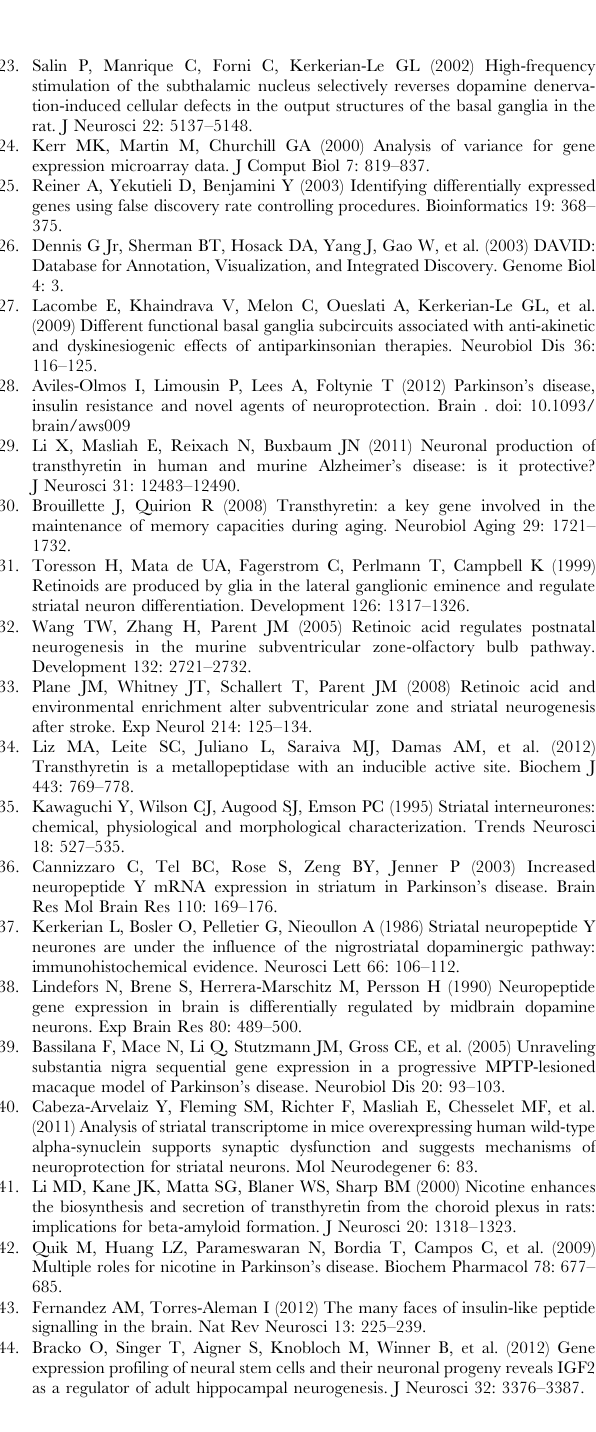
Table S7 Functional annotation chart: Most relevant biological terms associated with DOPA. Table S8 Functional annotation chart: Most relevant biological terms associated with